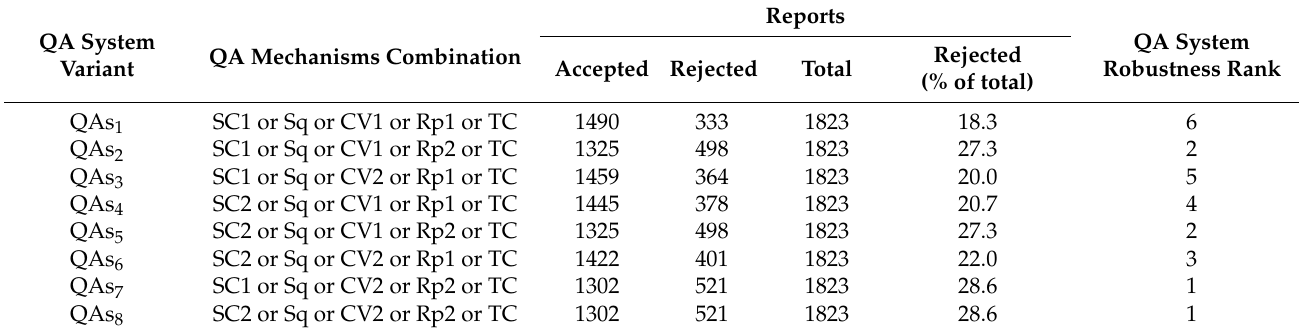
Table 6. QA system variant robustness.